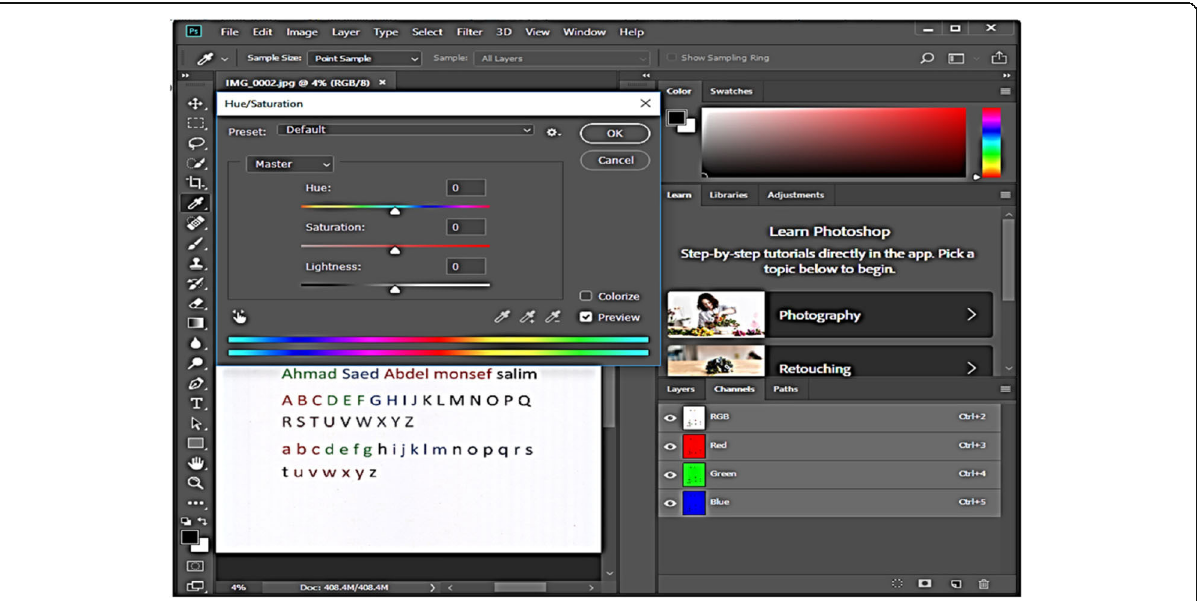
Fig. 5 The HSL window opened in Adobe® Photoshop® CC 2018 for the adjustment process